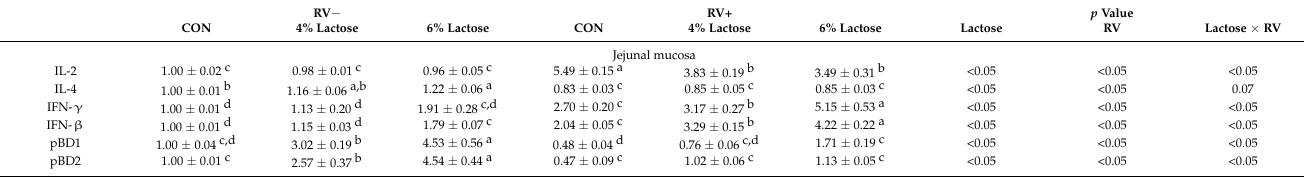
Table 10. Effect of dietary lactose supplementation and/or RV challenge on the gene expression of cytokines and host defense peptides in jejunal mucosa and/or mesenteric lymph nodes of weaned pigs 1 . RV −